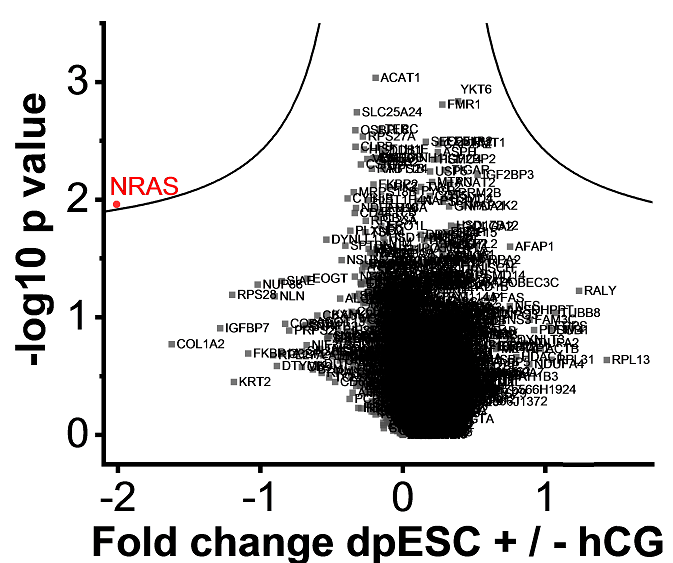
Figure 3. Volcano plots of cultured RIF decidualized primary endometrial stromal cell (dpESC) incubated for 24 h with and without 100 IU human chorionic gonadotropin (hCG)/mL. All protein names are shown, but only NRAS (marked in red) revealed a significant lower abundance after incubation with hCG.